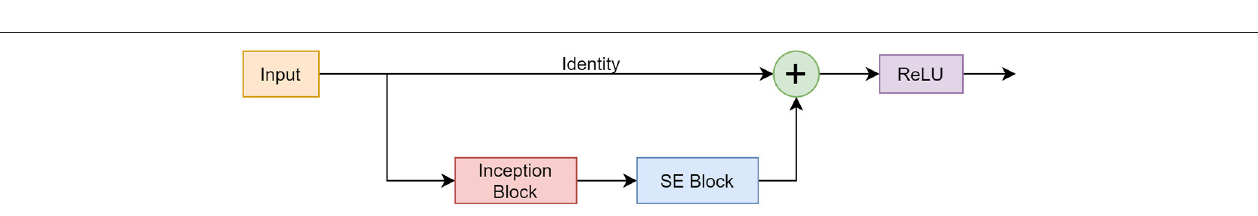
FIGURE 6 | Framework of the RISE module consisting of a skip connection, Inception block, and SE block.